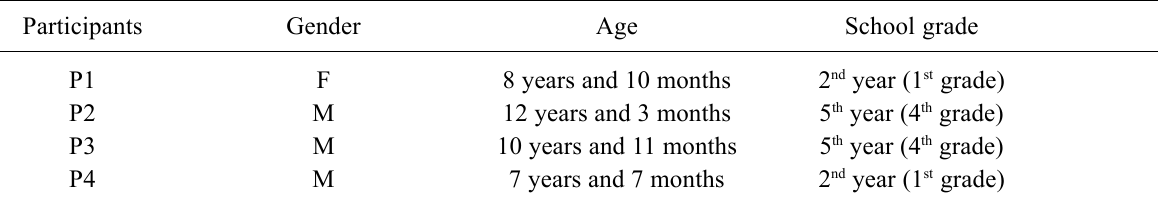
Characterization of the Participants of Study 1 By Gender, Age (Years and Months at the Beginning of the Study) and School Grade